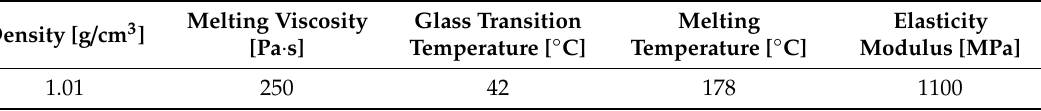
Table 3. Properties of Grilamid 12 [27].